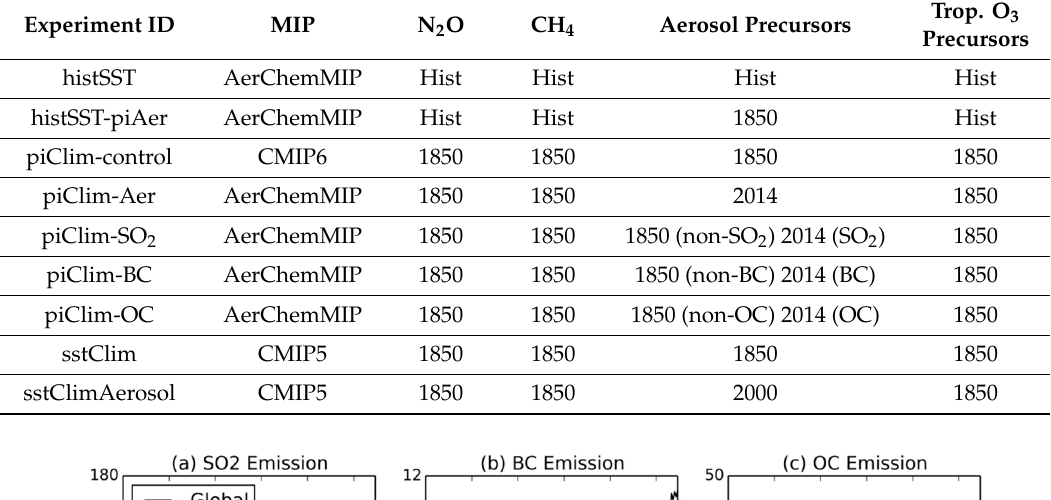
Table 1. List of all the fixed historical sea surface temperature e ff ective radiative forcing (ERF) experiments used in the study to diagnose the pre-industrial to historical period ERFs from changes in aerosol emissions.